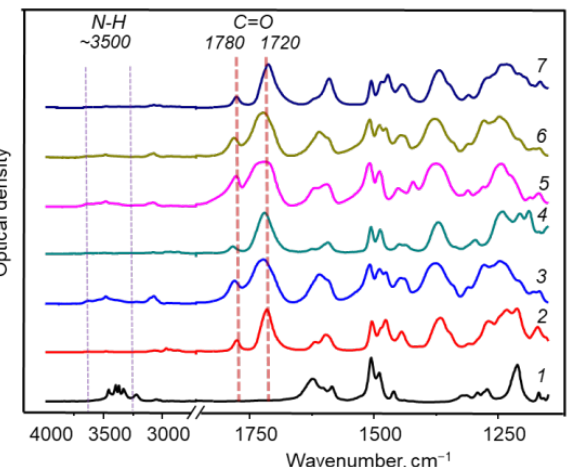
Figure 1. IR spectra of 3,4 ′ -ODA (1) and polyimides PI-DA (2), PI-ODPA (3), PI-6FDA (4), PI-BPTA (5), PI-BZP (6) and PI-RDA (7).